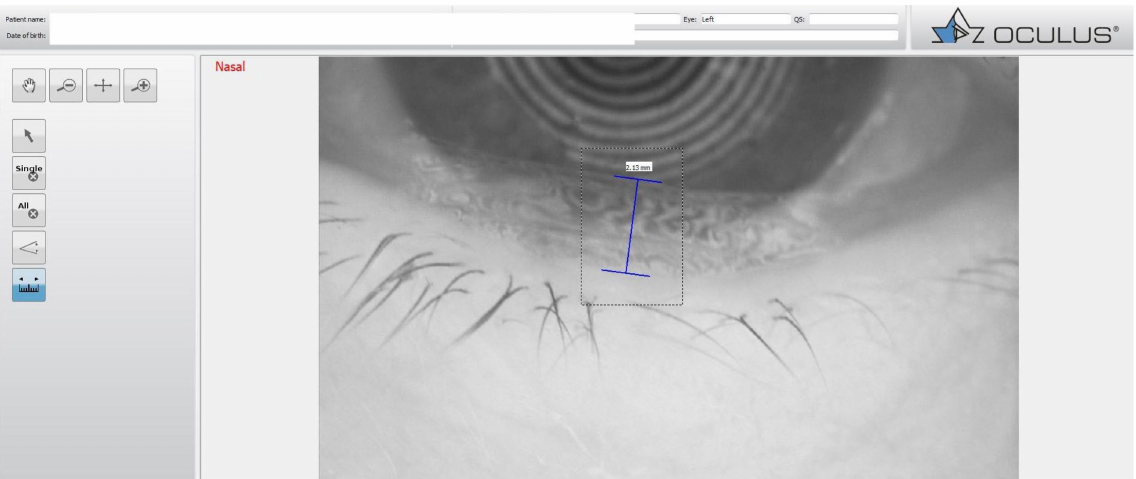
Figure 4. Tear meniscus height measurement artifact due to the presence of conjunctivochalasis. Image obtained with Keratograph5M (Oculus Optikgeräte GmbH, Wetzlar, Germany).